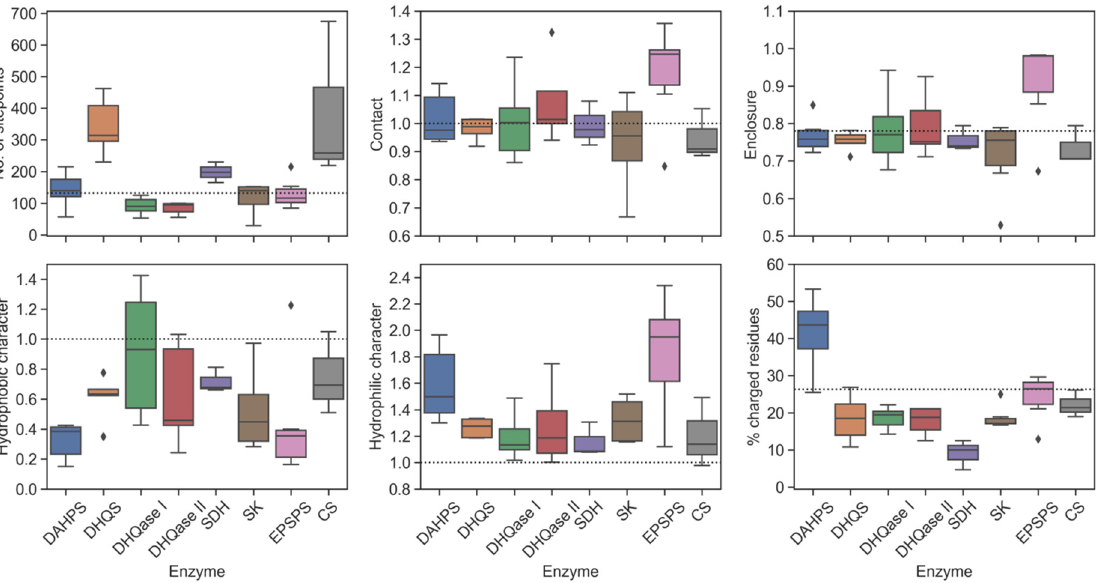
Figure 6. Key physicochemical properties of each enzyme in the shikimate pathway. The dotted line in each boxplot indicates a reference value for the average submicromolar site.